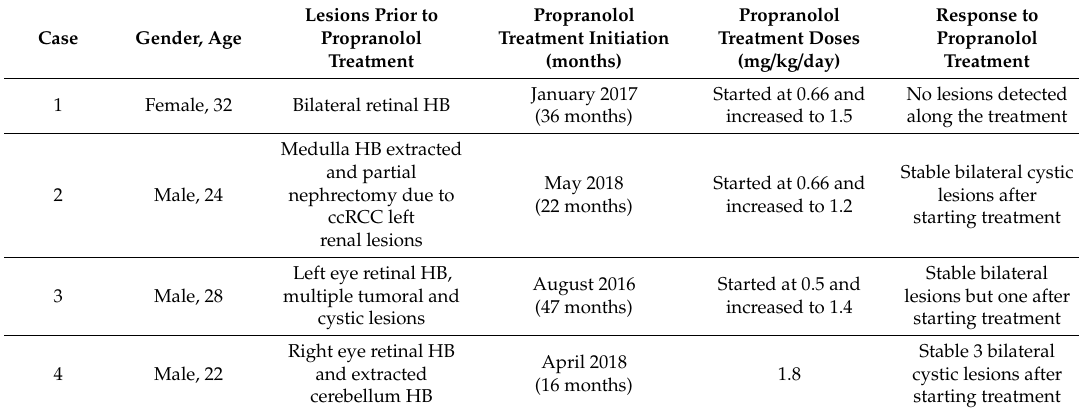
Table 2. Clinical monitoring of VHL patients with retinal HBs receiving propranolol in an o ff -label treatment: previous lesions, dosage, and response to the